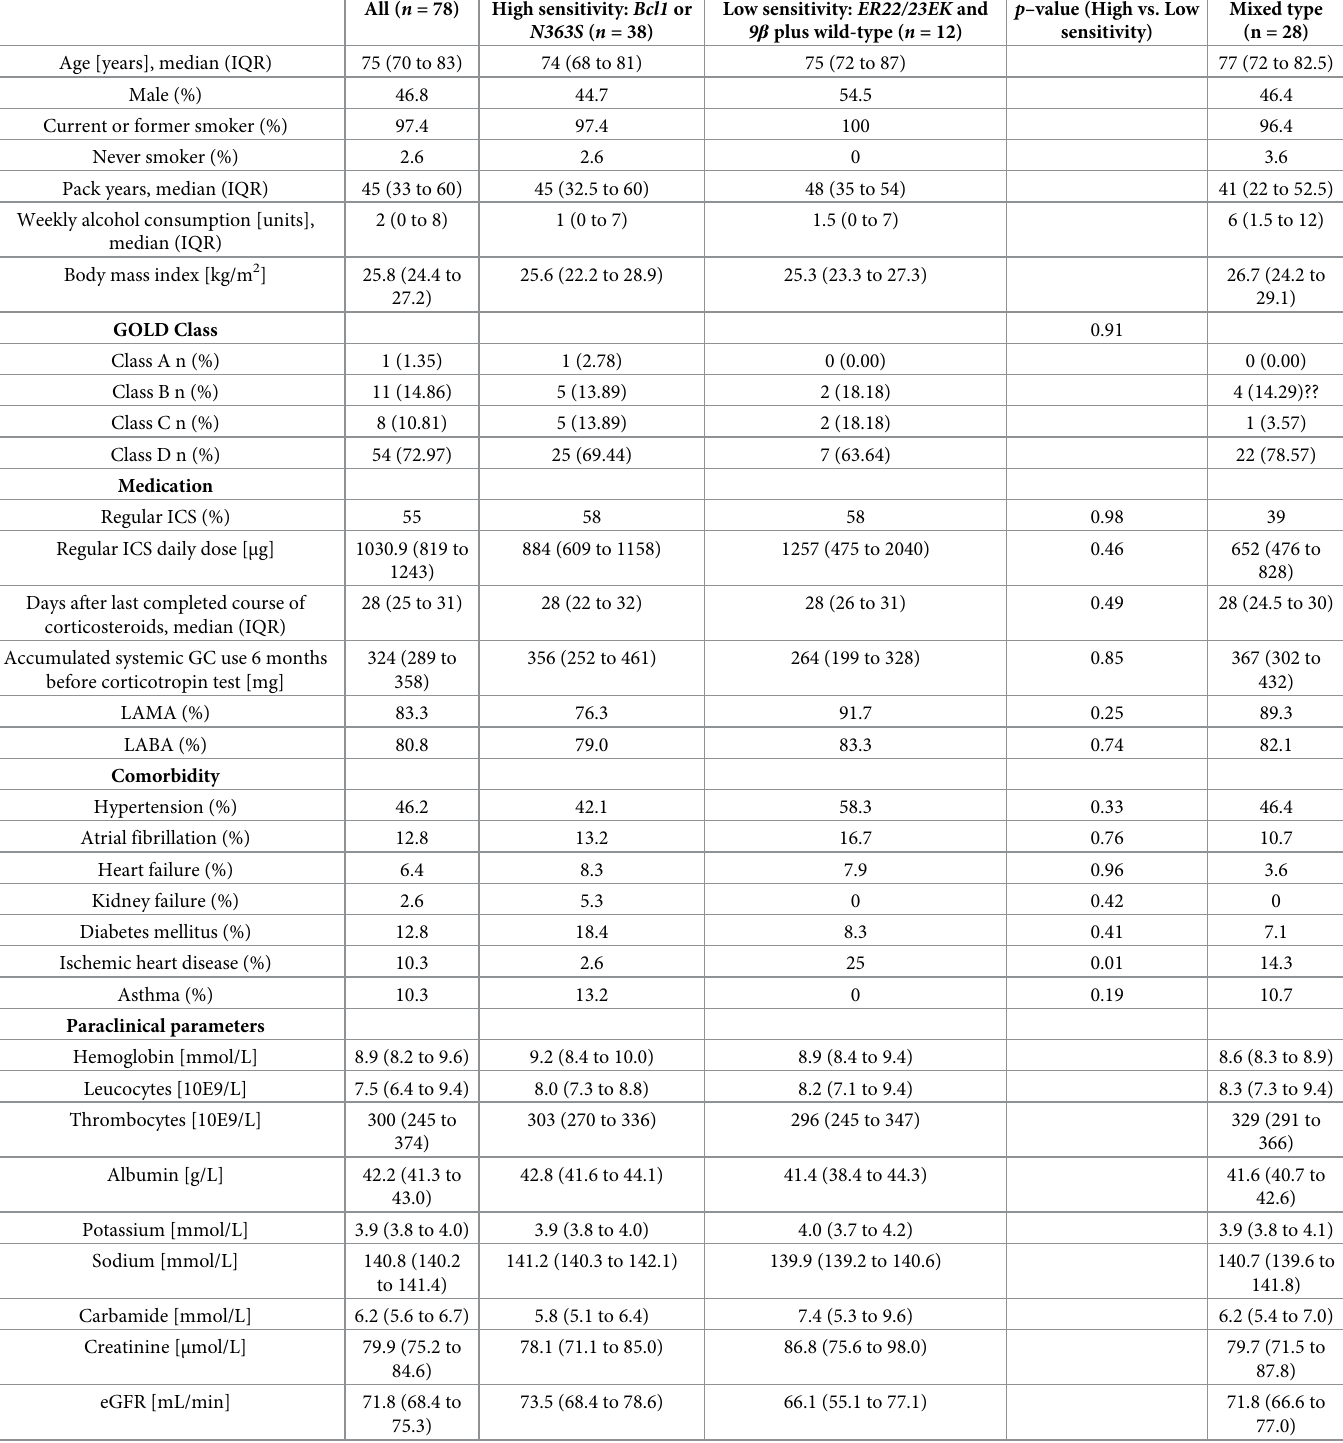
Table 1. Clinical, functional, and biological characteristics of COPD patients with high-sensitivity haplotypes, those with low-sensitivity or wild-type haplotypes, and ‘mixed type’, i.e. patients with a mixture of high-sensitivity and low-sensitivity genotypes. Mixed type was excluded from haplotype analyses. All ( n = 78) High sensitivity: Bcl1 or Low sensitivity: ER22/23EK and Mixed type p –value (High vs. Low sensitivity) (n = N363S ( n = 38) 9 β plus wild-type ( n = 12)